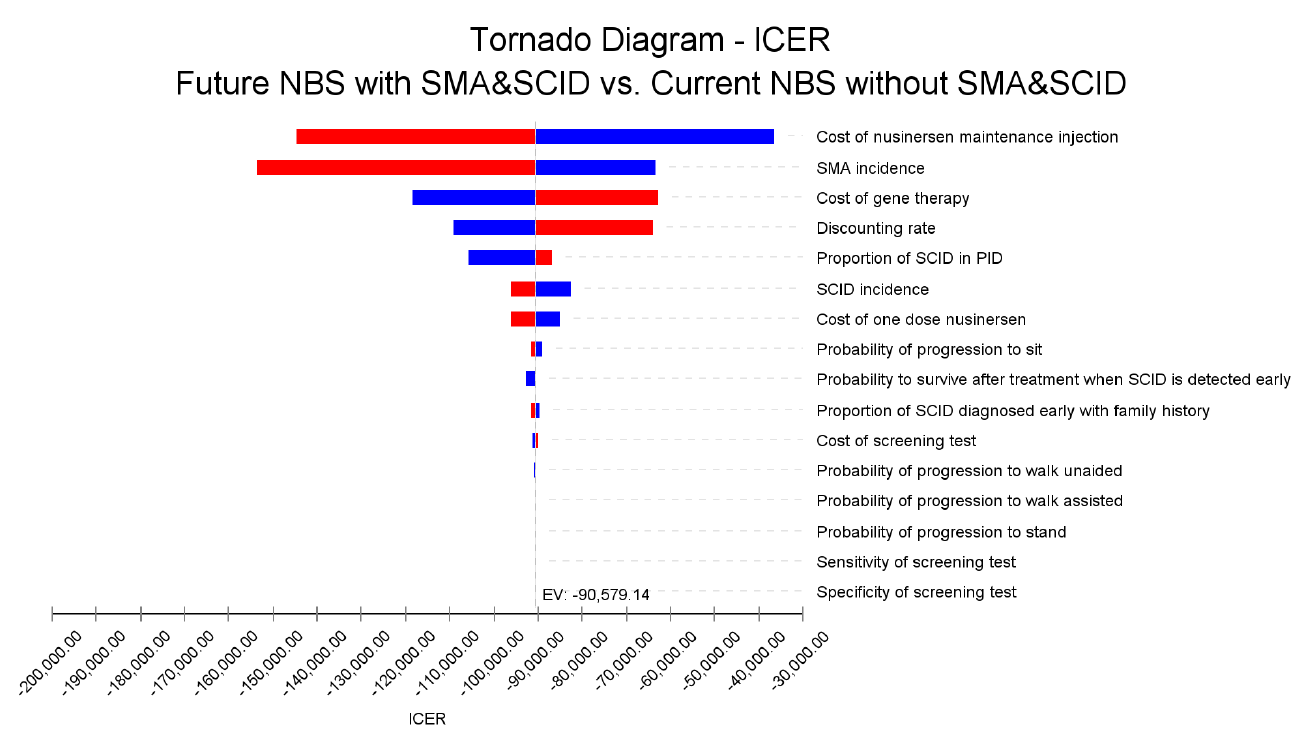
Figure 3. Tornado diagram of the one-way sensitivity analysis showing the impact of key parameters on the ICER for combined NBS for SCID and SMA, government perspective, 60 years, USD 2018. Note: Red bars indicate an increase in the parameter value from the base case value 257 (Expected Value, EV line) and blue bars show otherwise.